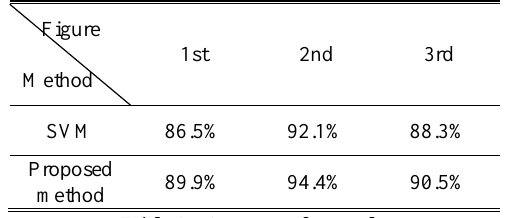
Figure 14. Detection comparisons. (a) Input image. (b) Binary result of SVM. (c) Detection result of SVM. (d) Binary result of proposed method (e) Result of proposed